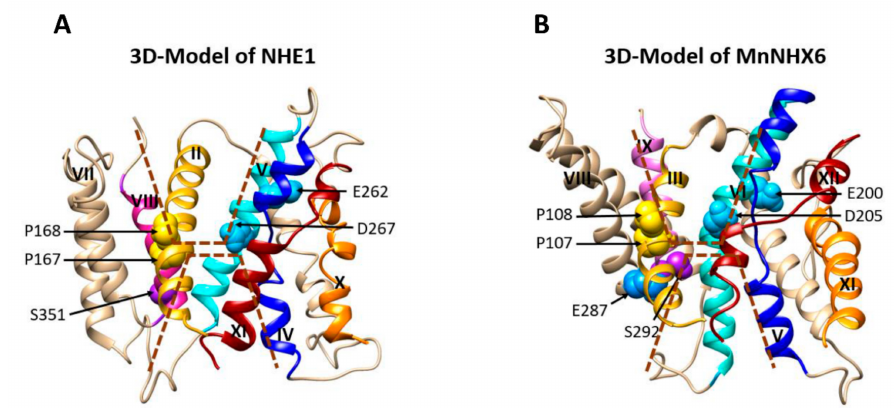
Figure 6. MnNHX6 and NHE1 share similar transport mechanisms. ( A ) In the NHE1 model, the cation- transport pathway is formed by two discontinuous funnels comprised of TM2, 4, 5, and 9 at the cytoplasmic side and TM2, 8, and 11 at the luminal side. Pro167 and Pro168 are located at the bend of the TM2 helix and play important structural roles for ion translocation. Glu262 (TM5) is located in proximity to the